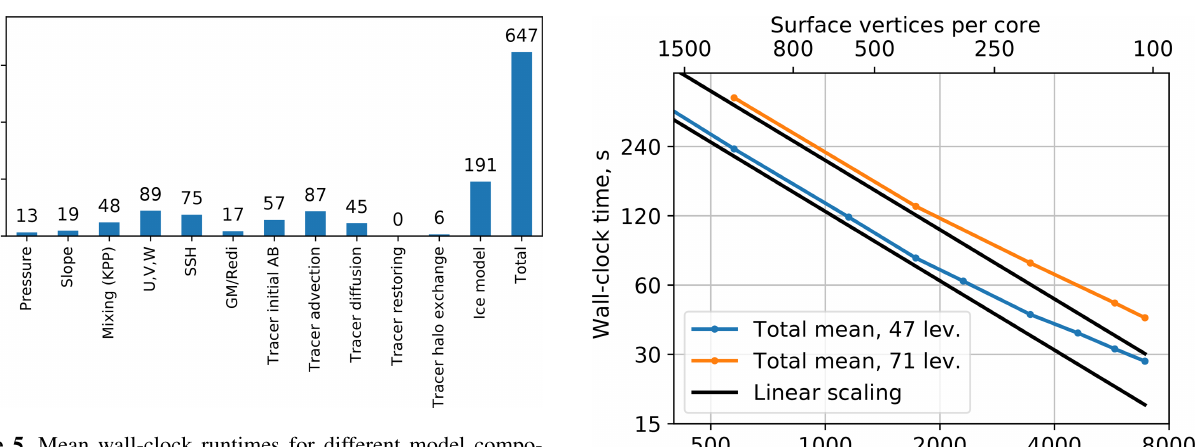
Figure 5. Mean wall-clock runtimes for different model compo- nents. The experiment is run for 1 year (11680 time steps of 45min) of CORE2 mesh on 288 cores on Ollie/AWI. “Pressure” includes computations of density and the Brunt–Väisälä frequency, and “Slope” includes computations of isoneutral slope.